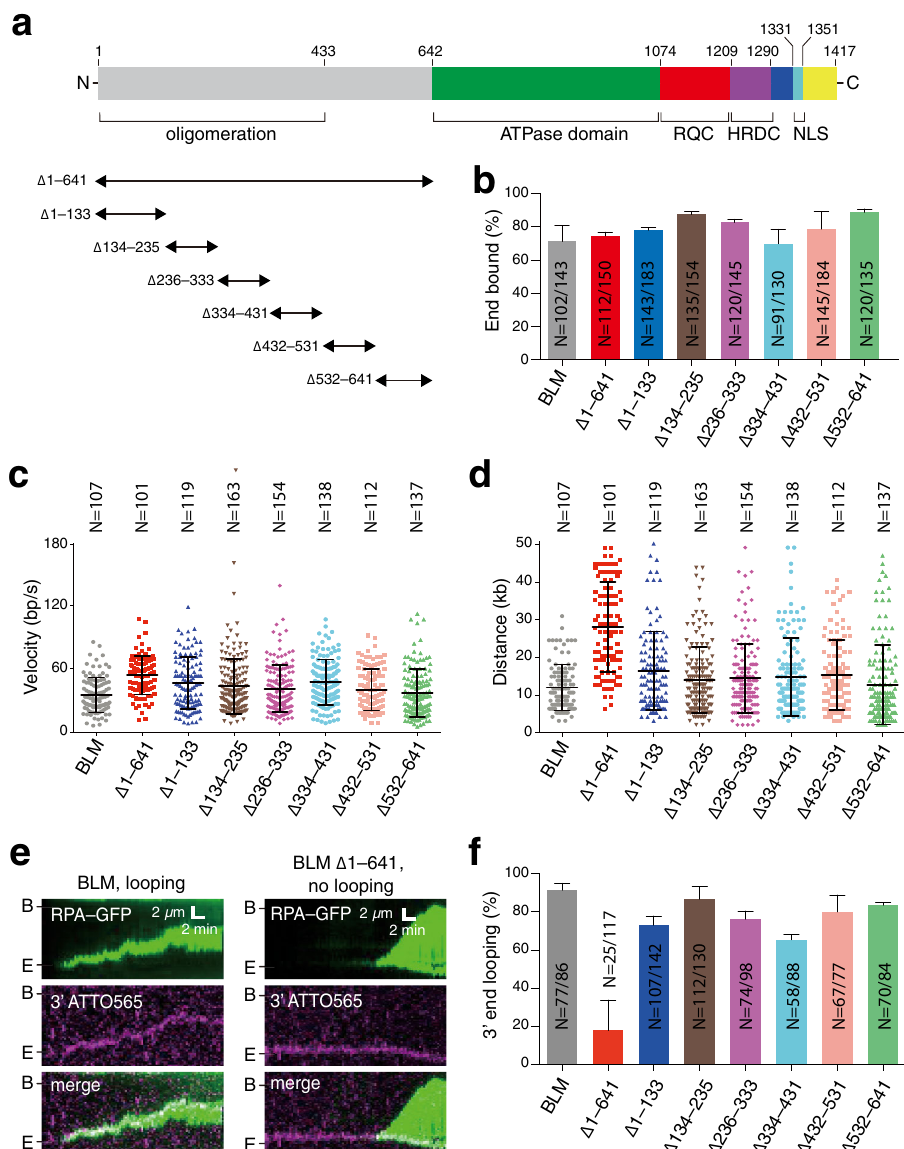
Fig. 4 The N-terminal domain of BLM is required for ssDNA loop formation. a Schematic showing the domain organization of BLM. Black arrowheads indicate the NTD truncation mutants analyzed in this study. b Fraction of DNA end-bound complexes for each BLM mutant. The height of each bar represents the percentage end-bound BLM molecules and error bars represent 95% con fi dence intervals (CI) calculated from bootstrap analysis. Also see Supplementary Fig. 4. c Velocity distributions for the BLM NTD truncation mutants compared to full-length BLM. Reactions contained 0.2 nM BLM (or the indicated BLM mutant) and 2 nM RPA but did not contain DNA2. The center bar represents the mean of the data and error bars represent SD. Also see Supplementary Table 1. d Processivity of the BLM NTD truncation mutants compared to full-length BLM. Reactions contained 0.2 nM BLM (or the indicated BLM mutant) and 2 nM RPA but did not contain DNA2. The center bar represents the mean of the data and error bars represent SD. Also see Supplementary Table 1. e Kymographs showing examples of full-length 0.2 nM BLM or 0.2 mM BLM Δ 1 – 641 and 2 nM RPA-GFP (green) in reactions with a 3 ′ ATTO565 (magenta) end-labeled DNA substrate. f Fraction of 3 ′ end looping events for each different BLM NTD deletion protein. The height of each bar represents the percentage DNA molecules that exhibit 3 ′ end looping and error bars represent 95% con fi dence intervals (CI) calculated from bootstrap